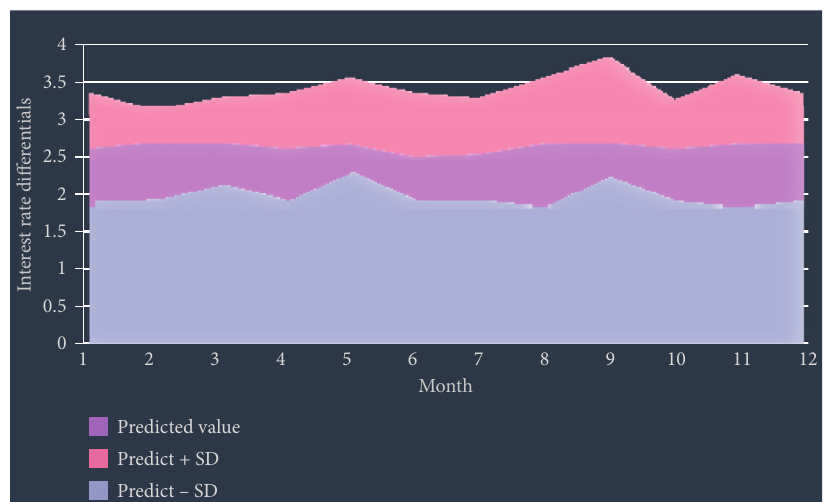
Figure 8: 2020 forecast data of domestic and foreign real deposit interest rate differentials.